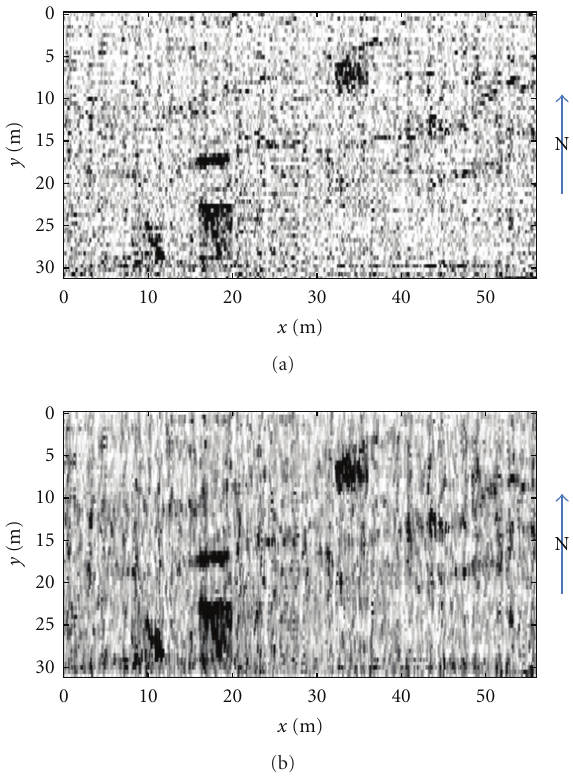
Figure 13: Tomographic constant depth slice at 1.25m: (a) section not interpolated; (b) section interpolated by a median